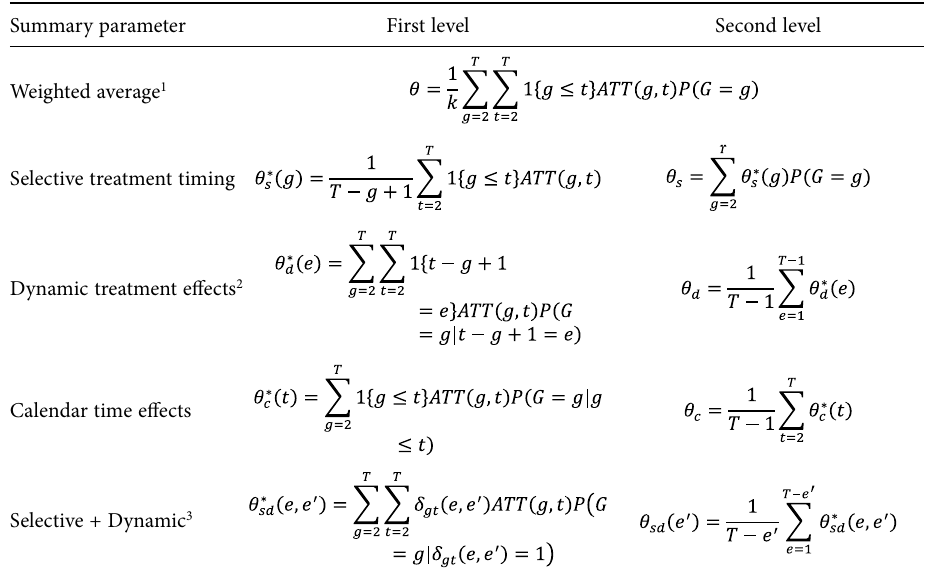
Table 1. Summary Parameters of the ATT Proposed by Callaway and Sant’Anna